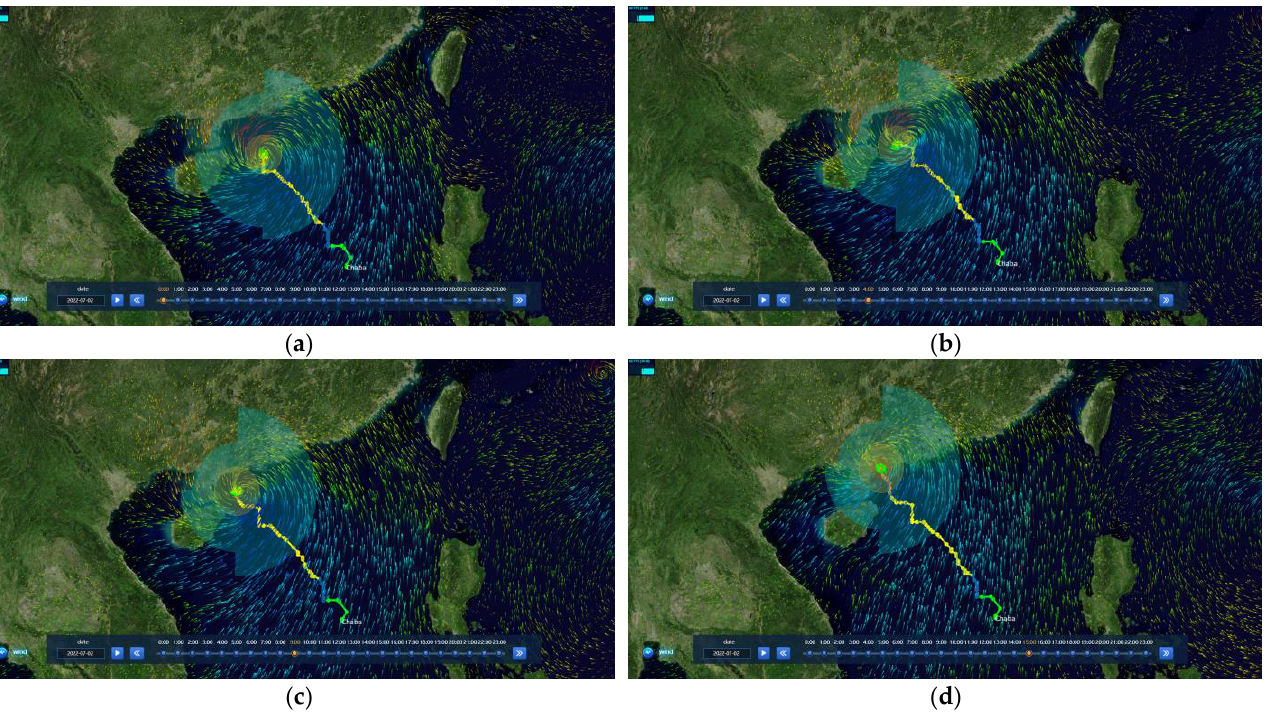
Figure 11. Wind-based time-varying particle tracking. ( a ) is the wind field at 0:00 on 2 July 2022. ( b ) is the wind field at 4:00 on 2 July 2022. ( c ) is the wind field at 9:00 on 2 July 2022. ( d ) is the wind field at 15:00 on 2 July 2022. Figure 11a–d are the corresponding wind fields at 0:00, 4:00, 9:00, and 15:00 on 2 July.